Question: Which visualization type does this figure use?
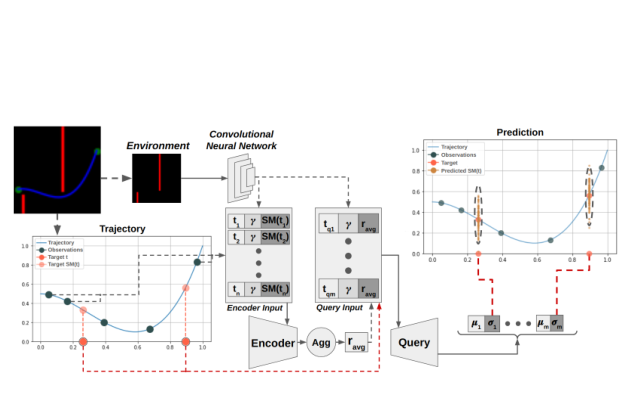
Answer: bar